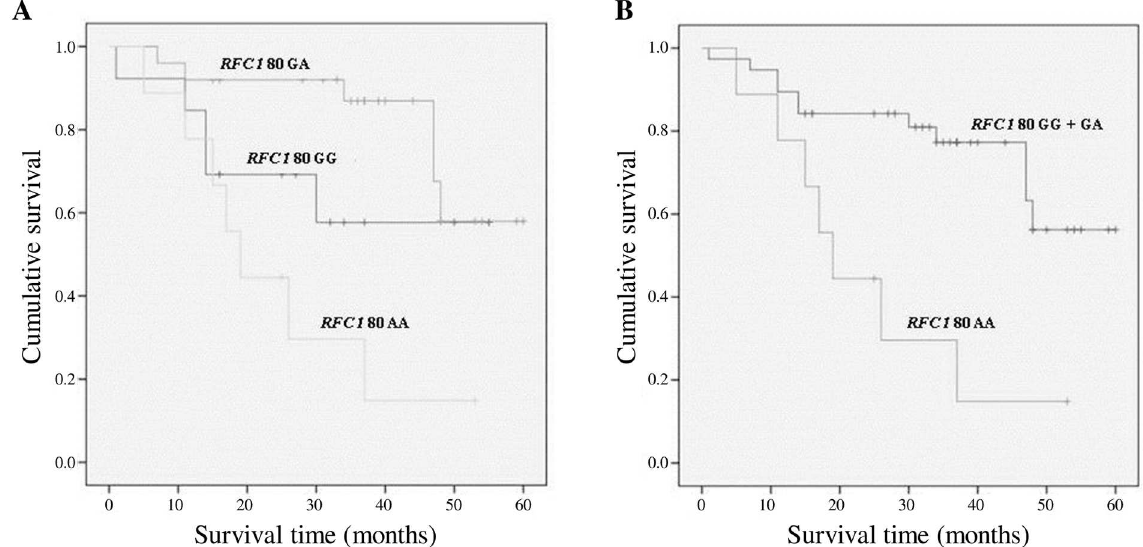
Fig 1. Survival curves plotted by Kaplan-Meier analysis according to RFC1 80G > A genotypes. (A) The survival rate was worse in RFC1 80AA (22.2%) patients as comparedto the RFC1 80GA (76%) and RFC1 80GG (61.5%) genotypes (p = 0.005). (B) The survival rate was lower among the RFC1 80 AA patients as comparedwith the G allelecarriers ( RFC1 80GG + GA )(p = 0.002). The percentage of survivors was 22.2% and 71.1%, respectively.